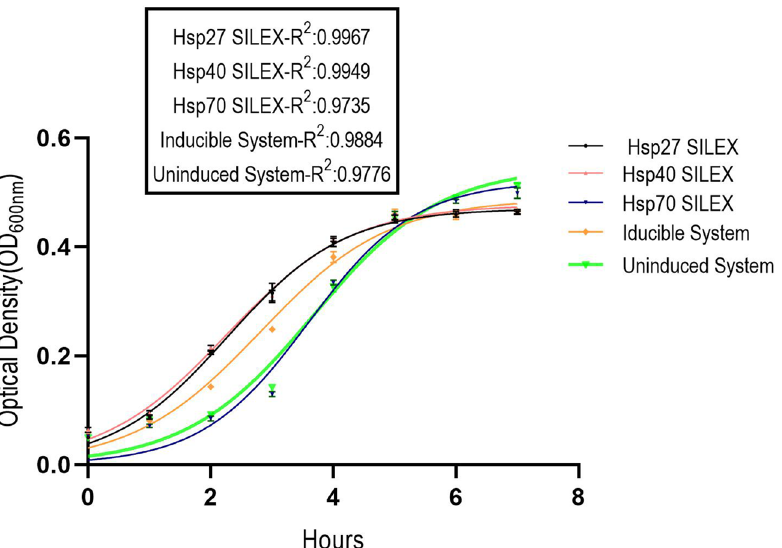
Figure 2. The nonlinear regression (Logistic growth) of bacterial growth curves for the inducible and autoinducible expression systems. Escherichia coli BL21 (DE3) strain containing pET28a-EGFP was evaluated as a control. Data are represented as Mean ± SD form three independent measurements.